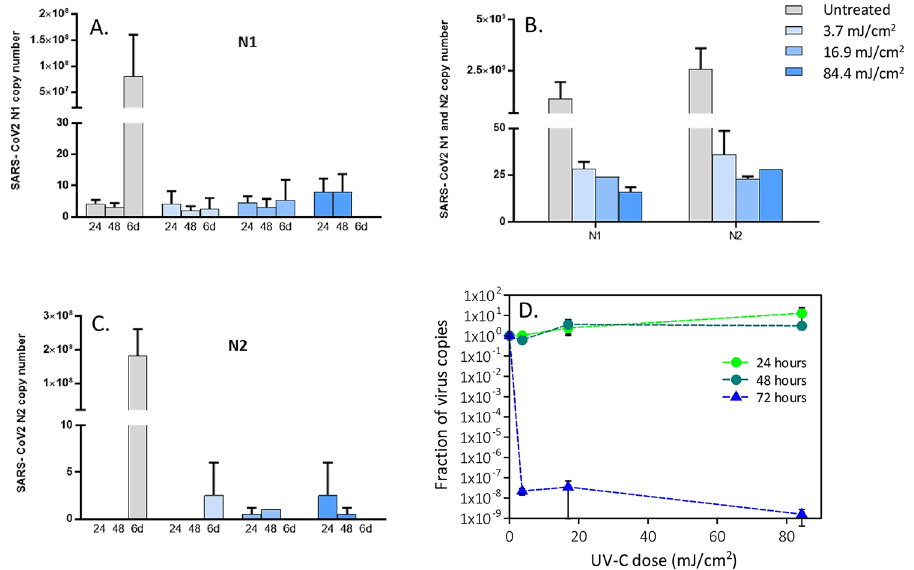
Figure 1. Viral replication of UV-irradiated SARS-CoV-2 (0.05 MOI) virus in in vitro VeroE6 cells. Vero E6 cells were infected with UV-C irradiated SARS-CoV-2 virus at a MOI of 0.05. Culture supernatants were harvested at the indicated times (24, 48 h and 6 days) and virus titers were measured ( A , B ) by absolute copy number quantification (Real-Time PCR). Viral replication was assessed even on cell lysate harvested at the end of cell cultures (6 days) ( C ). All cell culture conditions were seeded in duplicate. Panel ( D ) reports the plots of the measured virus copies normalized at the untreated sample in the different conditions. For descriptive purposes, mean values and whiskers representing the observed half-ranges are